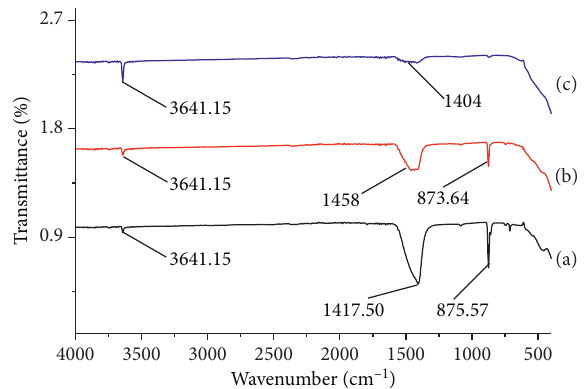
Figure 6: FTIR spectra of (a) Ca(OH) 2 (black), (b) CaO-NPs calcined at 800 ° C (red), and (c) CaO-NPs at 900 ° C